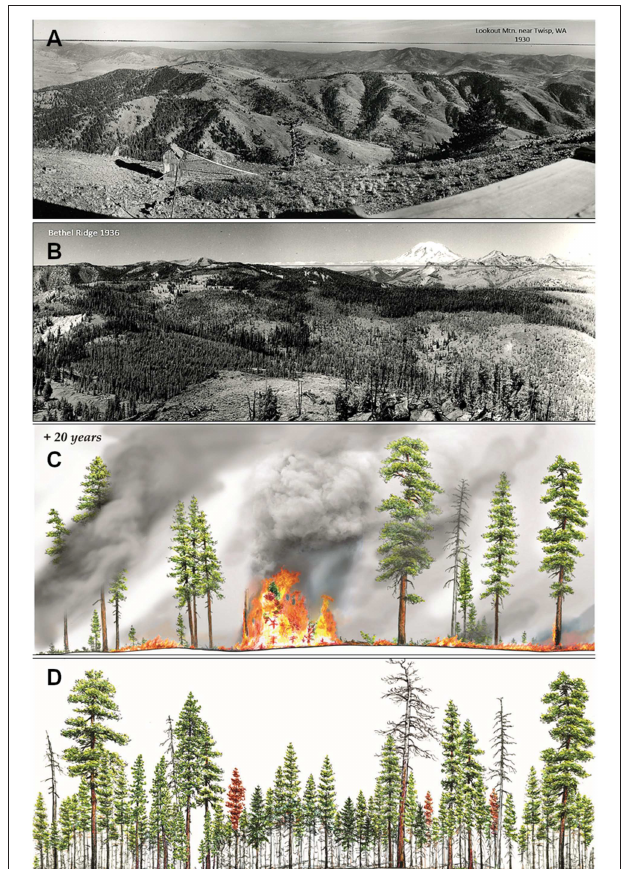
FIGURE 5 | (A) Landscapes were hierarchically nested throughout ecoregions of western North America. Broad-scale physiognomic patchworks formed the upper level. Grasses, herbs, and/or shrubs were the primary fuels, which tended to perpetuate a frequent grass-fire cycle, often yielding mollisols. This broad-scale patchwork functioned as a relatively fast fire delivery system by day, and by night as a fire spread dampening system, where fuel moistures recovered with the night-time relative humidity. Presence of this non-forest-forest patchwork afforded a broad-scale resilience context for the embedded forest. Fires delivered to the forest edge were more often relatively low energy in comparison to modern-era fires. (B) Forest successional landscapes occurred at a meso-scale, and they resided within the larger physiognomic landscape. Forest successional conditions varied by time since fire and reburn frequency. Where reburning was common and reburned patches were small to medium sized, forest successional conditions developed with little or no woody surface fuels, which later led to a low probability of crownfire initiation in the event of a wildfire. With increasing time since fire, forests would encroach on larger grass, shrub, and woodland patches. In areas with long time since fire, forest successional conditions would become more homogeneous, with forest density and layering increasing within and among forest successional patches. Variability in surface fuels and forest successional conditions influenced variability of fire severity and sizes of fire severity patches, which increased both the resistance and resilience of the forest successional landscape. (C) At a relatively fine scale, patches functioned as small landscapes within the larger successional landscape. Especially in dry and moist mixed conifer patches with low or moderate severity fire regimes, tree regeneration and mortality patterns were clumped and gapped, with both clump and gap sizes roughly following an inverse-J distribution. Frequent to moderately frequent wildfires (e.g., every 5–30